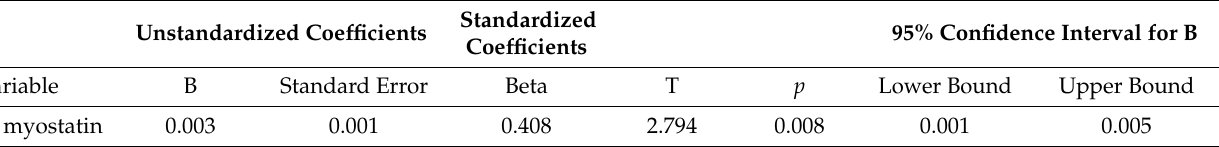
Table 3. Relationships between myostatin and BMI assessed by stepwise multiple regression analyses.